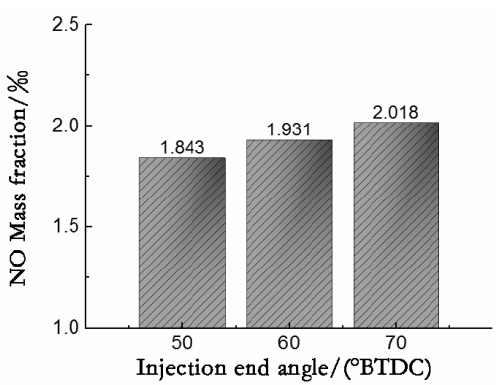
Figure 18. NO data corresponding to different injection end angles.